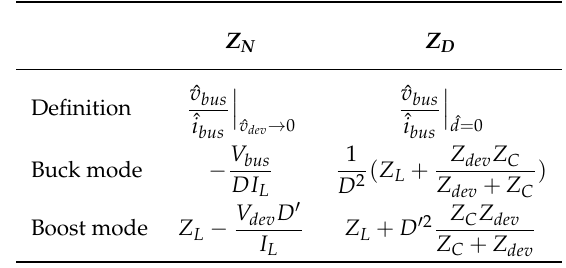
Table 5. Definition and derivation of Z N and Z D for a device-regulating converter.